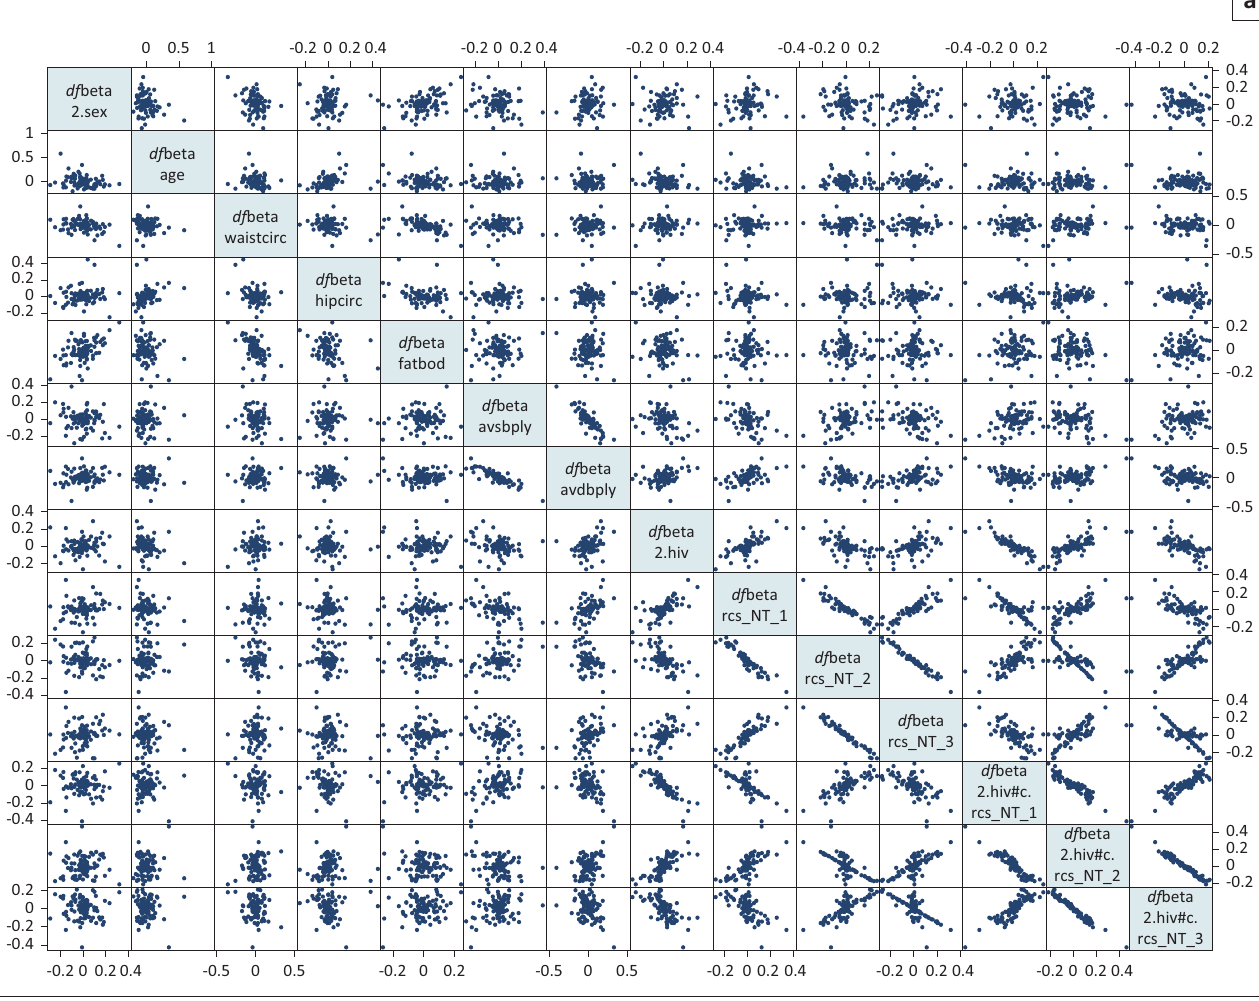
Figure 1-A1 continues on the next page →